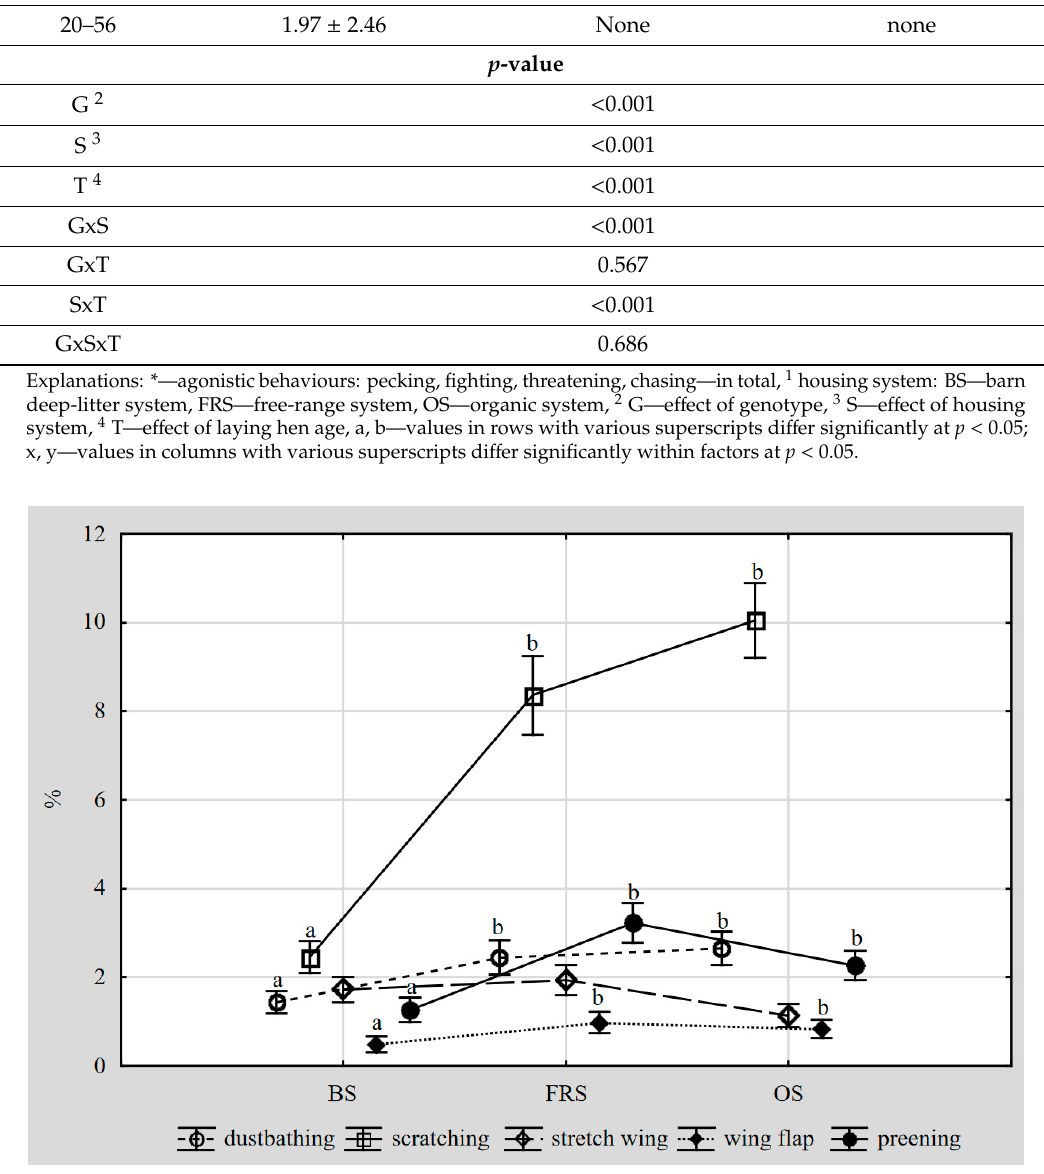
Figure 1. Percentage of different forms of comfort behaviour in the studied housing systems Explanations: housing system: BS—barn deep-litter system, FRS—free-range system, OS—organic system; a, b—values with different letters within the form of behaviour differ significantly at p < 0.05. The percentage of birds displaying comfort behaviours depended on the housing system, genotype and hen age (Table 3). The proportion of layers engaged in comfort behaviours in the free- range system (FRS) and organic system (OS) was similar ( p > 0.05), and almost twice as high as in the deep-litter BS ( p < 0.05). In the FRS and OS, the percentages of birds displaying dustbathing, scratching, wing flapping and preening were similar ( p > 0.05) and higher than in the BS ( p > 0.05) (Figure 1). In all housing systems, scratching dominated amongst all the comfort behaviours (Figure 1). In the FRS and OS systems, the proportion of comfort behaviours rose with hen age ( p < 0.05). In all production systems, the Z-11 hens presented a greater percentage of birds displaying comfort behaviours than the Hy-Line Brown hens ( p < 0.05). Independently of bird age, at all assessment times, different forms of agonistic behaviour (pecking, fighting, threatening, chasing) were observed only in the deep-litter system (BS) but no agonistic behavioural patterns were noted in conditions of the free-range (FRS) and organic (OS) systems. A higher percentage ( p < 0.05) of agonistic behaviours was observed in the Hy-Line Brown hen group behaviour (pecking—0.92%, fighting—0.25%, threatening—1.11%, chasing—0.36%) than in the Z-11 hens (pecking—0.50%, fighting—0.22%, threatening—0.36%, chasing—0.22%). In both the Hy-Line Brown and Z-11 groups, the proportion of agonistic behaviours declined with age (Table 4).